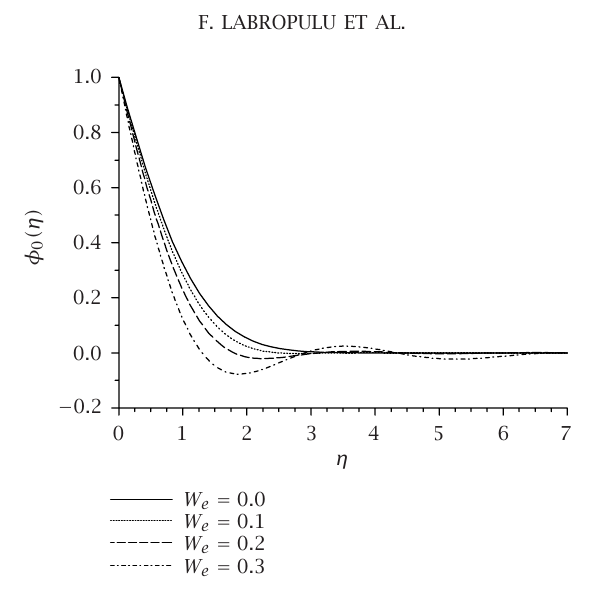
Figure 3.3 . Variation of φ